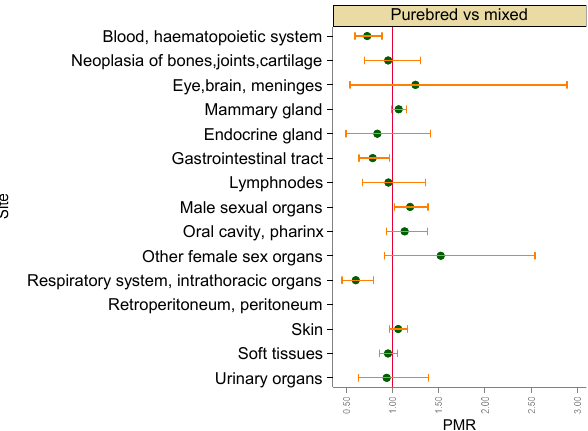
Figure 6. Proportional morbidity ratios of malignant tumours by topography comparing purebred dogs with mixed dogs. Dots: age-class-adjusted PMRs, bars: lower and upper bound of 95% confi- dence interval. A vertical reference line indicates PMR = 1.